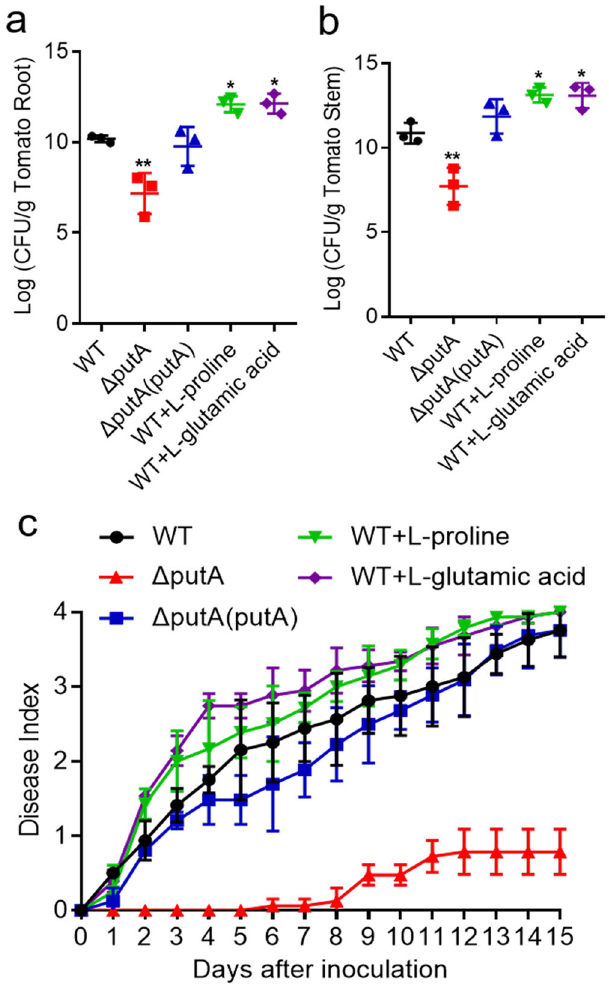
Fig. 6 In fl uence of PutA on the pathogenicity of R. solanacearum in tomato plants. CFUs of the R. solanacearum wild-type, wild-type treated with 1 mM L-proline and 4 mM L-glutamic acid, respectively, putA mutant and complemented strains in the roots ( a ) and stems ( b ) of tomato plants. The effects of putA on the virulence of R. solanacearum were measured by assessing the disease index of bacterial wilt in tomato ( c ). Unwounded tomato plants were subjected to soil-soak inoculation with 8 mL of bacterial culture (OD 600 = 1.0) and incubated at 28 ± 1 °C under a 12-h light/dark cycle with a relative humidity (RH) of 90%. Results in a , b and c are mean ± standard deviations of three biologically independent